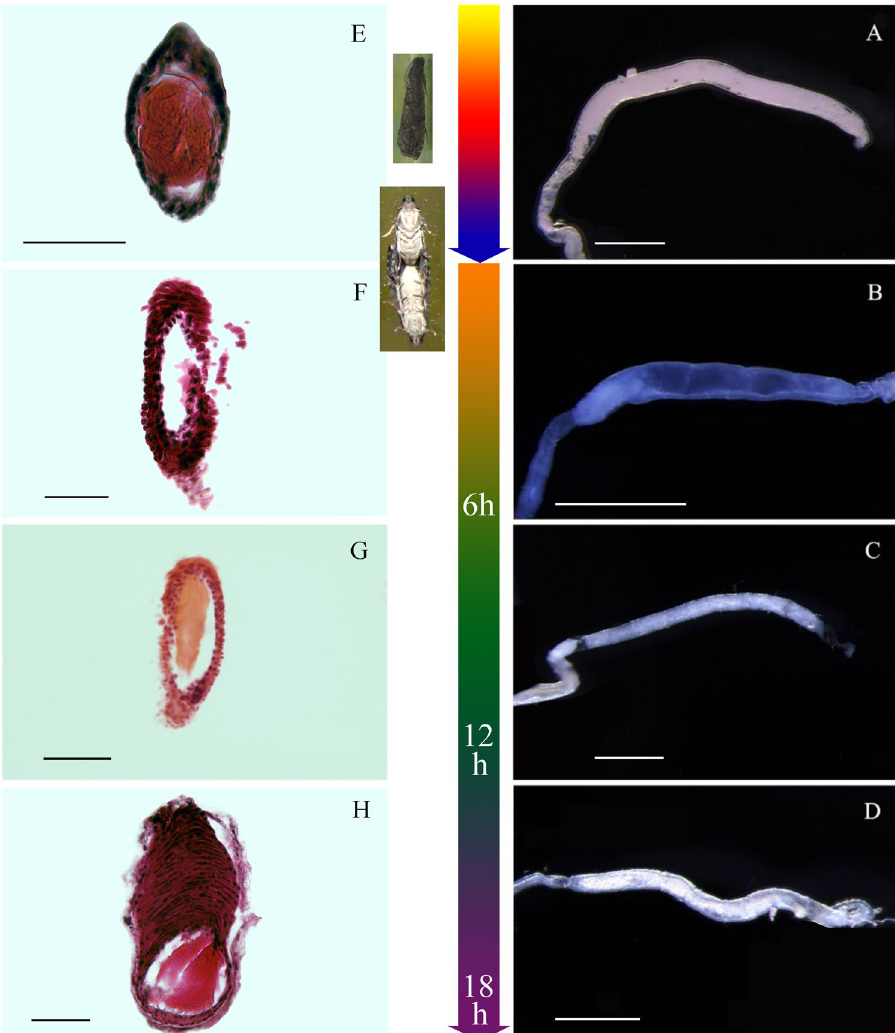
Figure 2. Morphology of the heavy muscular area of the ductus ejaculatorius simplex after mating (h: hours after mating). ( A ) Unmated males; ( B ) 0 to 6 hours after mating; ( C ) 12 hours after mating; ( D ) 18 hours after mating. Scales = 0.50 mm; ( E ) Semithin section of unmated males; ( F ) Semithin section of 6 hours after mating; ( G ) Semithin section of 12 hours after mating; ( H ) Semithin section of 18 hours after mating (oblique view). Scales = 0.050